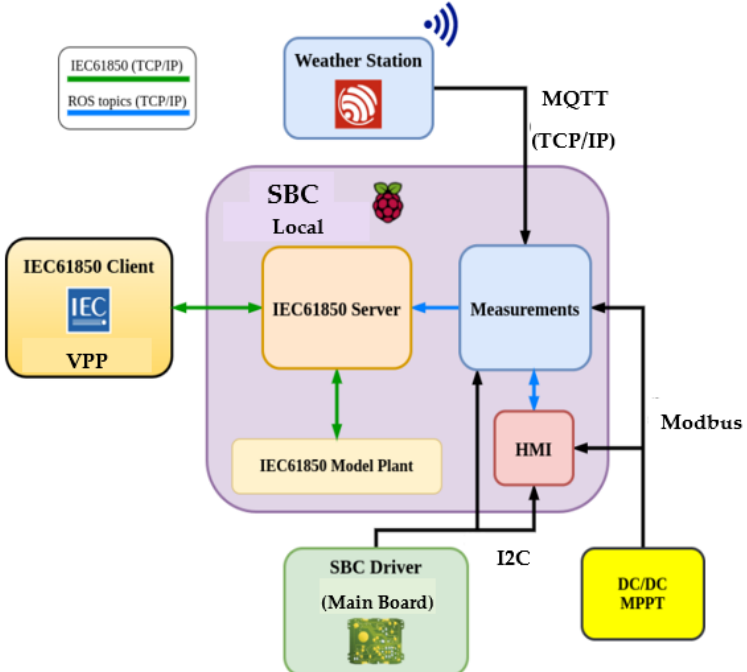
Figure 10. Communication protocols of the smart sensing system.